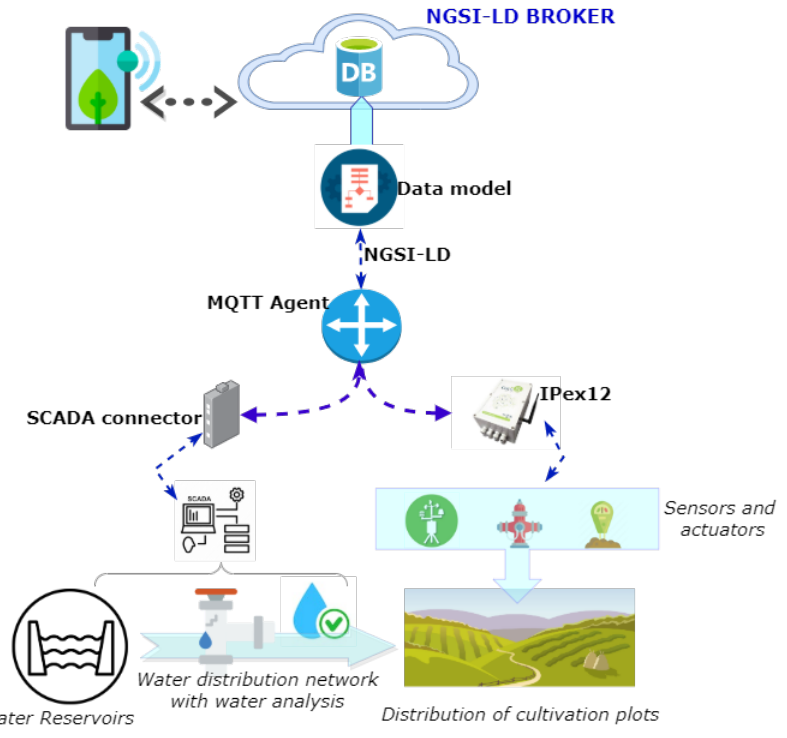
Figure 4. Layout of the case